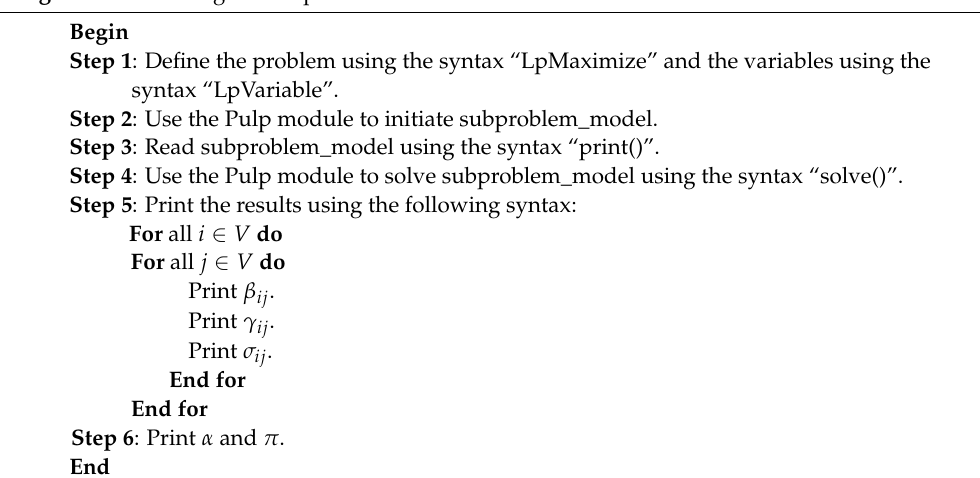
Algorithm 2: Solving the subproblem